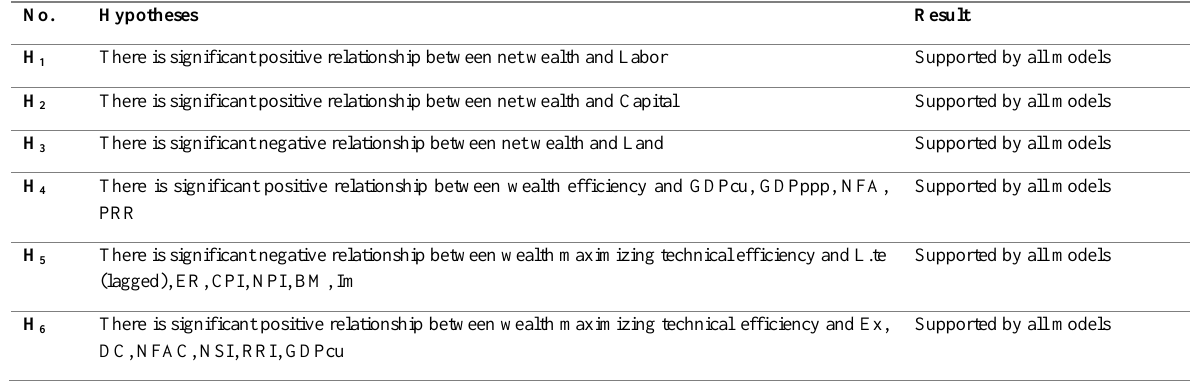
Table 14: Result of the test of hypotheses are given below: